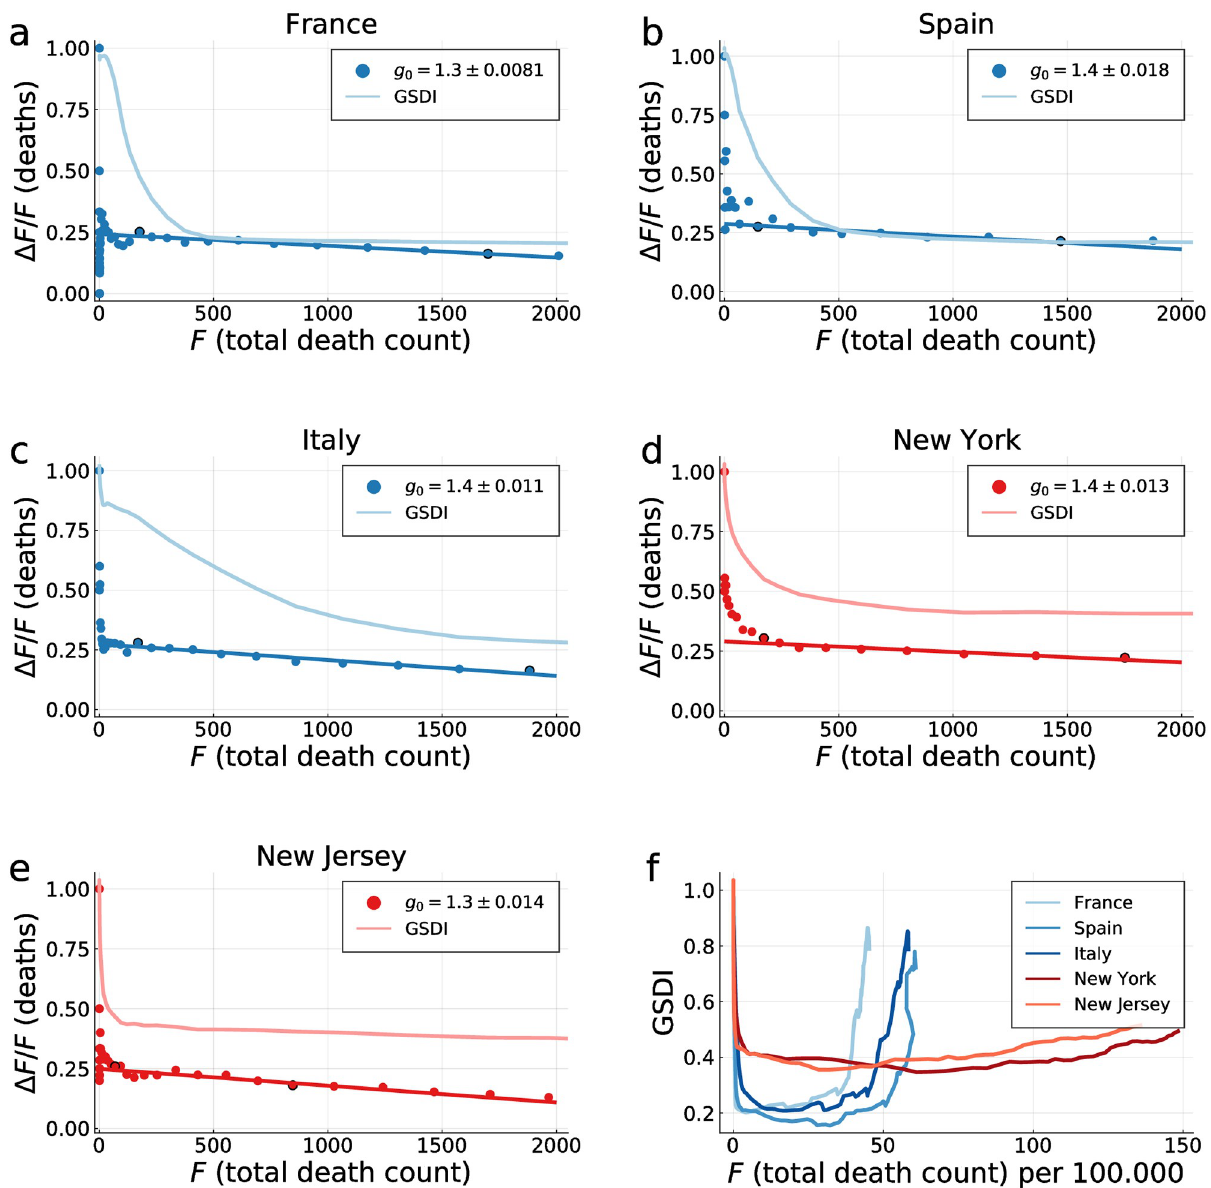
Fig 7. Fatalities vs. social distancing. Comparison of the Google social distancing index (GSDI), as defined in Google social distancing index (GSDI), with COVID-19 fatalities. a) - e) For France, Spain, Italy, New York and New Jersey. Shown is the ratio Δ F / F of the daily fatalities Δ F and the total death count F (filled circles), a linear fit between 2%–20% of the fatality peak (marked circles), and the respective GSDI. The slope has been used to calculate g 0 in accordance to Eq (21). f) The GSDIs on an expanded scale, now as a function of fatalities per capita (per 100,000). The selected European countries and US states show distinct